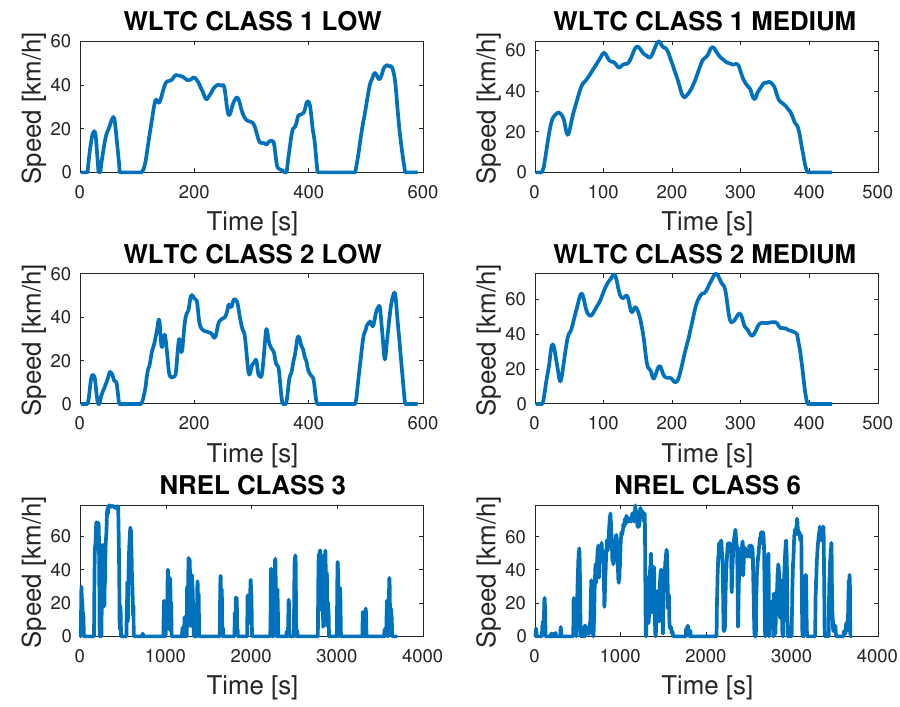
Figure 2. Driving Cycles for